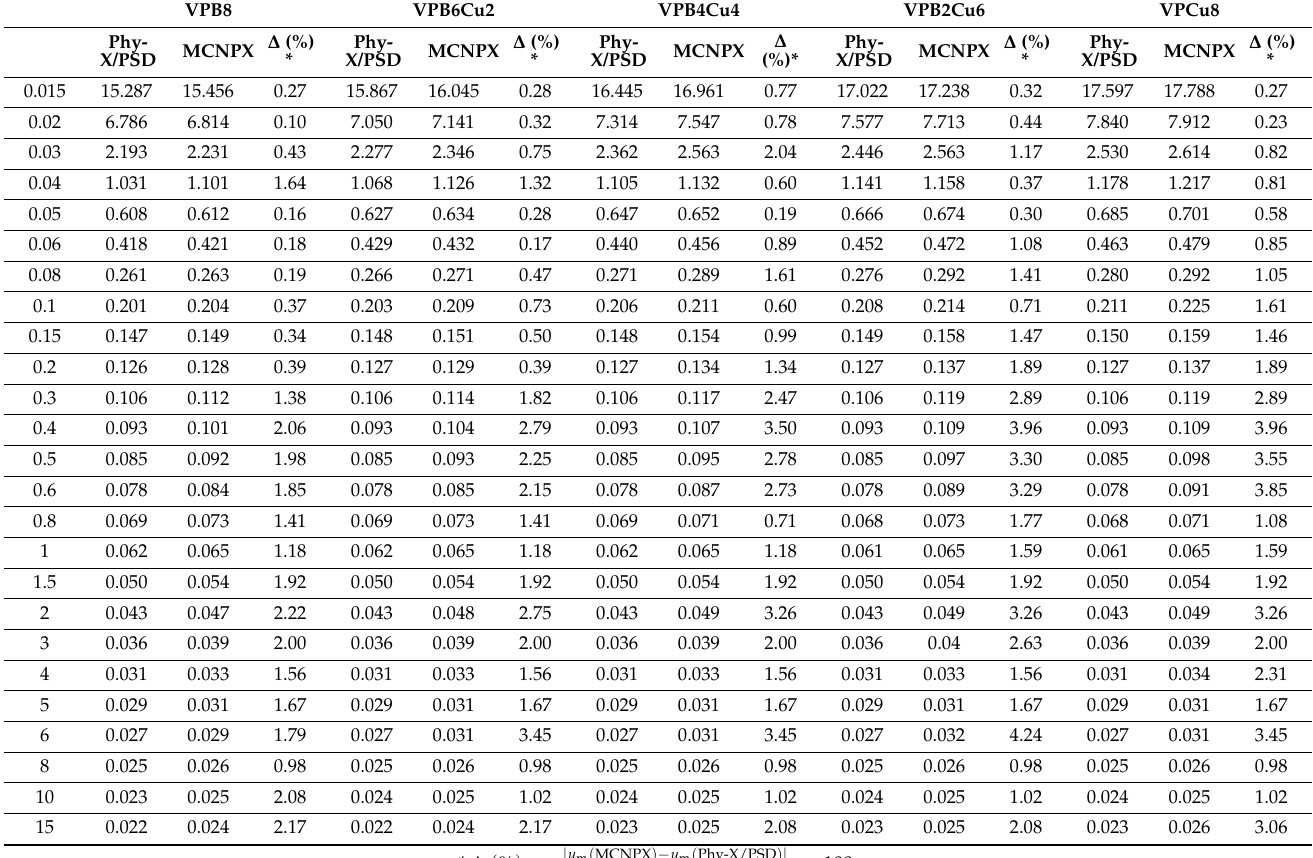
Table 2. The obtained mass attenuation coefficients ( µ m ) of VPB x Cu y glasses from Phy-X/PSD program and MCNPX (v. 2.7.0) code along with %